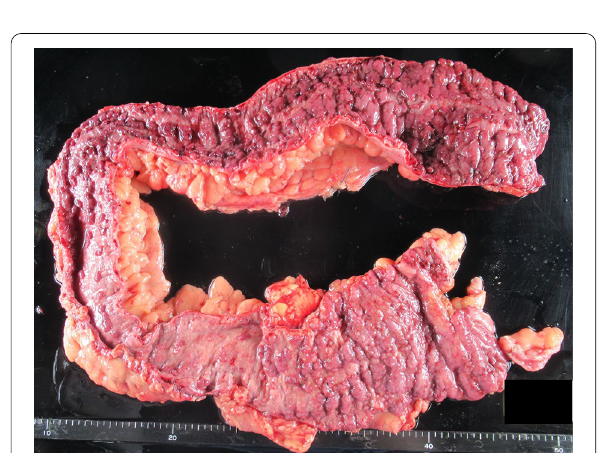
Fig. 6 Excised specimen. Ulcers were spreading throughout the